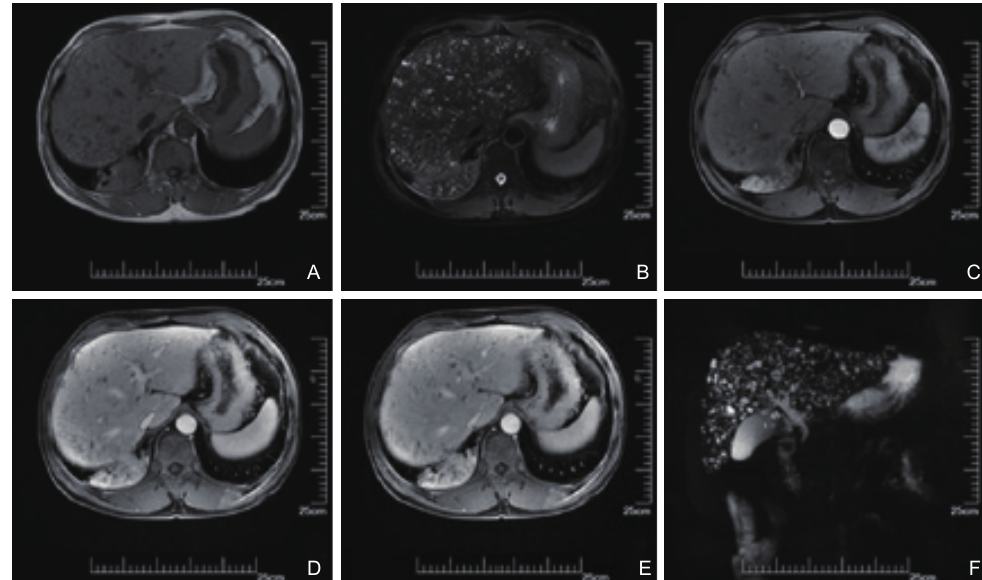
Figure 3 The MRI plain scan and contrast-enhanced abdominal MRI showed the lesions on T1- weighted image (A), T2- weighted image (B), arterial phase (C), portal venous phase (D) and delayed period phase (E) and MRCP showed the lesions